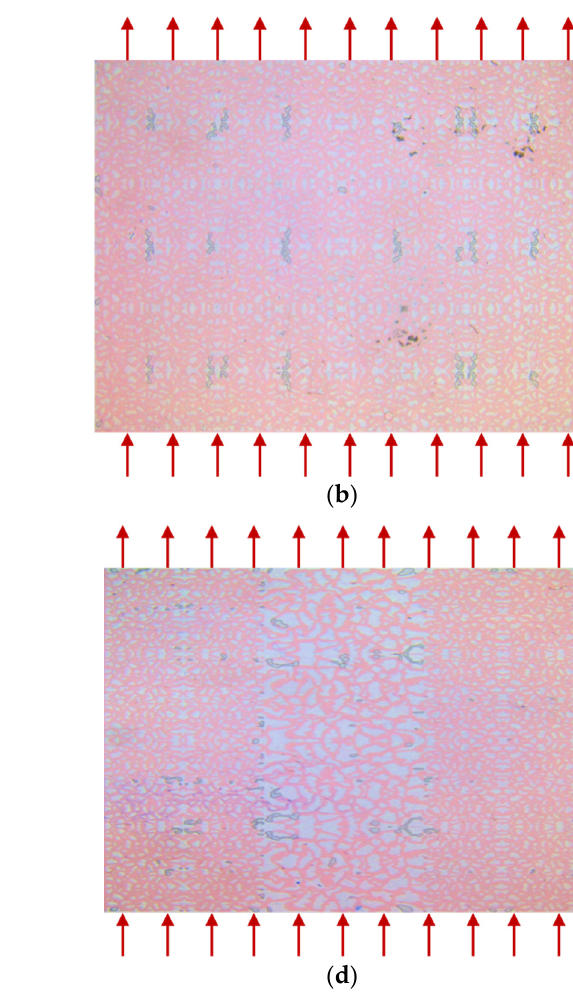
Figure 1. Two types of microfluidic models. ( a ) The schematic diagram of the homogeneous model; ( b ) the homogeneous model; ( c ) the schematic diagram of a heterogeneous model; ( d ) the heteroge- neous model.